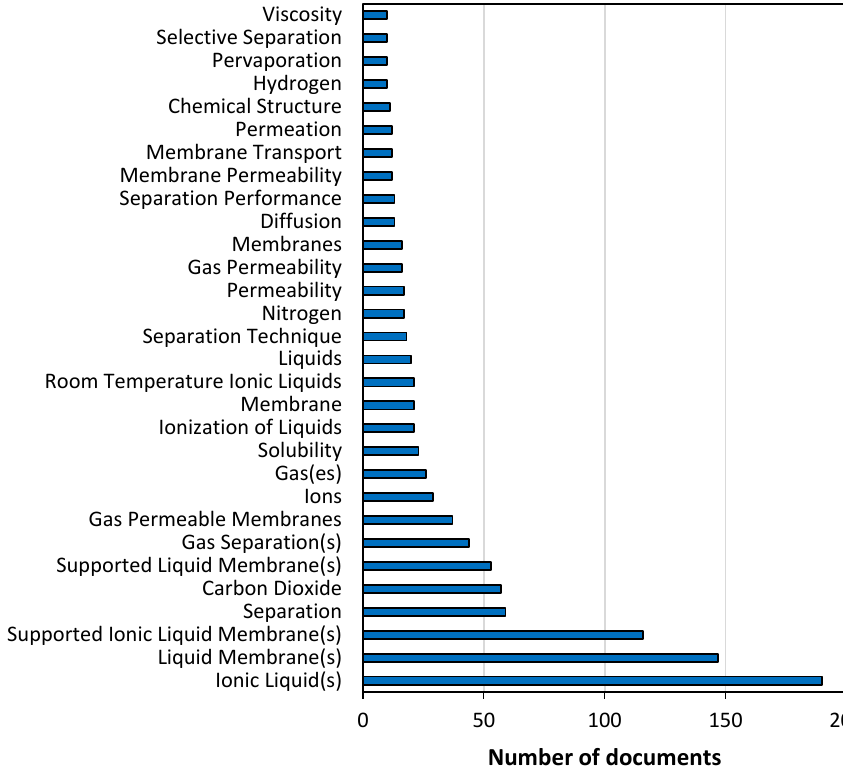
Figure 3. Most frequently used keywords.